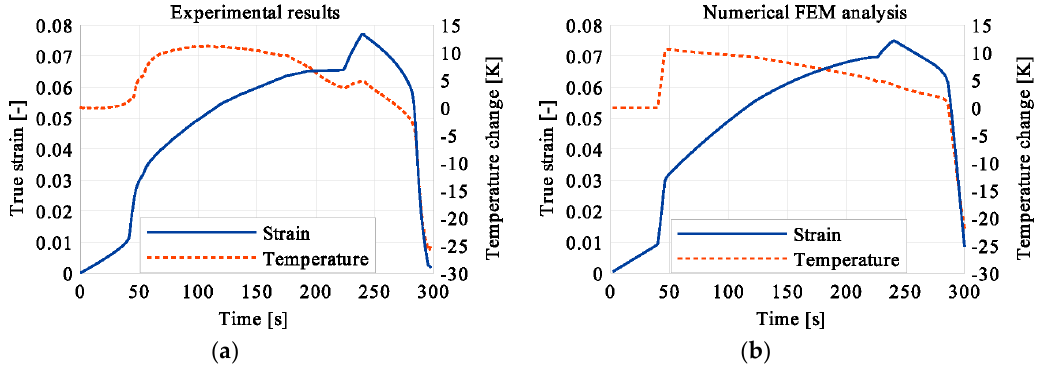
Figure 10. Strain and temperature variations vs. time for the loading program (2): 3-min loading interruption in the middle of the LMT: ( a ) experimental data; ( b ) numerical results.